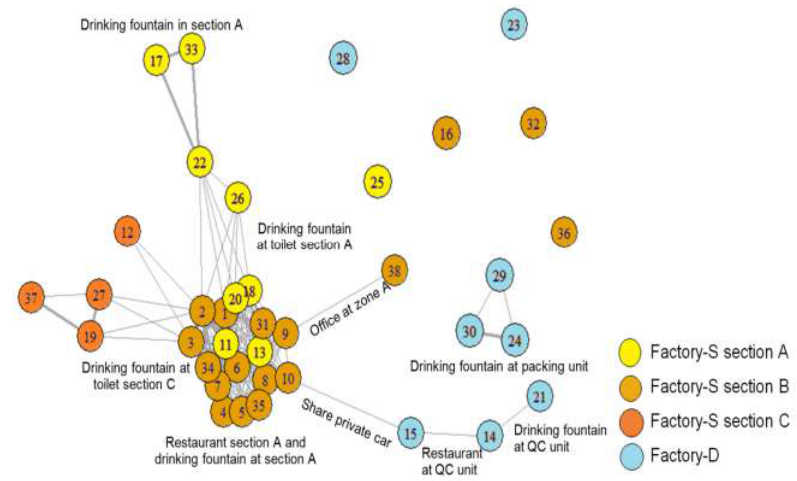
Figure 3. Sociogram illustrating the connection of cases ( N = 38). Note: The figure inside a bubble refers to the ordering number of a case, counted by onset date. Different colors of the bubbles indicate different working sections. The thickness of a line indicates the strength of network. A thin line means either physical contact (friends or roommates) or geographical contact (working in the same workplace), while a thick line indicates that the persons that linked together had both types of contact.